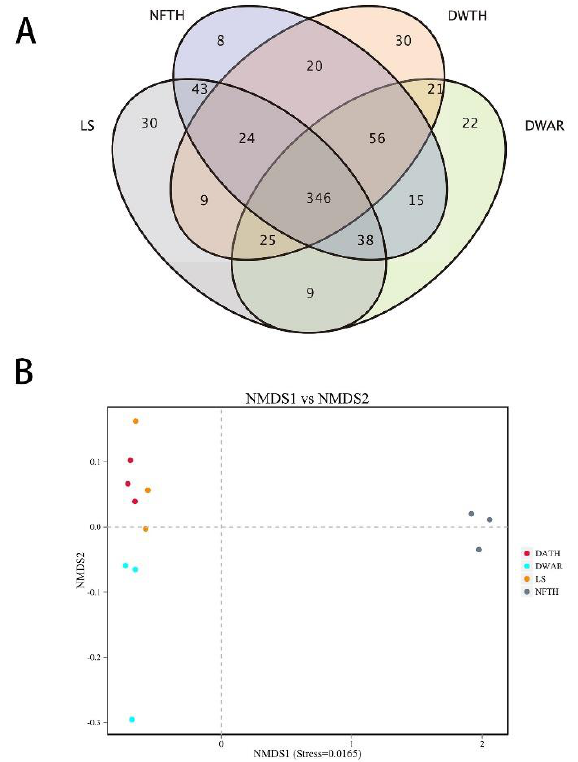
Figure 3. ( A ) Venn diagram showing the number of shared and unique genera in different parasitoids and their host. ( B ) Non-metric multidimensional scaling analysis based on the Bray–Curtis distance. DWAR, DWTH, LS, and NFTH represent arrhenotokous Diglyphus wani , thelytokous Diglyphus wani , Liriomyza sativae , and thelytokous Neochrysocharis formosa, respectively.